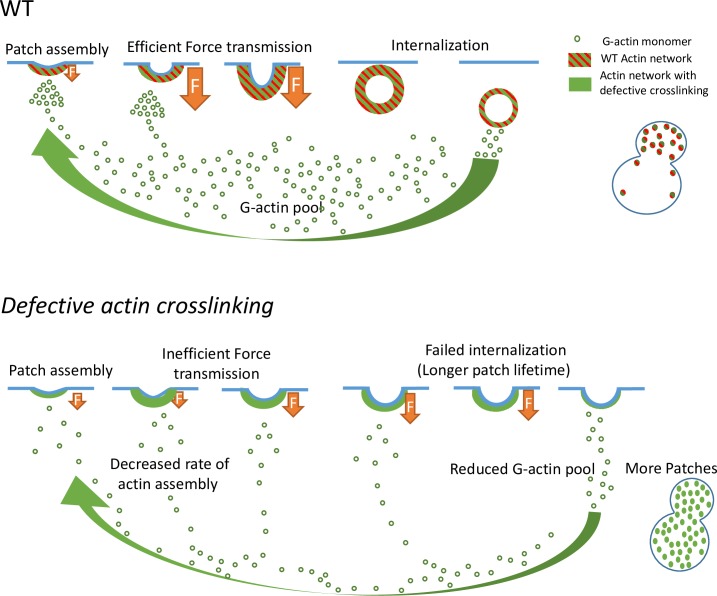
Schematic of a chain-of-consequence model for yeast endocytosis.This model proposes that in WT cells (upper panel), the mechanical properties of actin patches (green filled dots) are optimized for efficient force transmission at the plasma membrane (in blue) and a rapid internalization of the endocytic vesicles. Subsequently to the internalization of an endocytic vesicle, the actin network disassembles and contributes to replenishing the limiting pool of actin monomers (green open dots) up to a normal level. In mutant strains, defective actin crosslinking (crosslinkers are in red) impacts the stiffness of actin networks. Force transduction to the membrane is less efficient, increasing actin patch lifetime and the proportion of failed endocytic events. Longer lifetime of actin patches for an equivalent frequency of endocytic events initiation accounts for a higher number of actin patches in these mutant cells. Because the pool of actin monomers is limiting, an increased number of actin patches means that more actin is polymerized in cells and that less monomeric actin is present. Depletion of the pool of monomeric actin leads to a reduced rate of actin assembly, which causes further failures of endocytosis. WT, wild type.